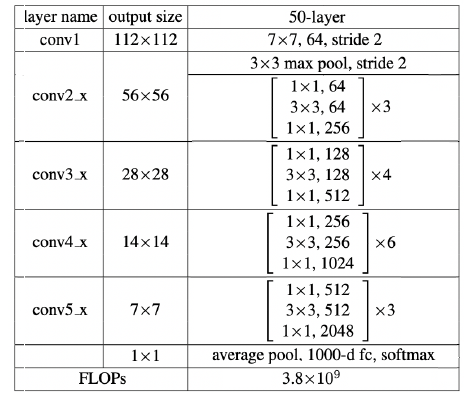
Table 1. ResNet50 building blocks (adapted from (He et al., 2016))